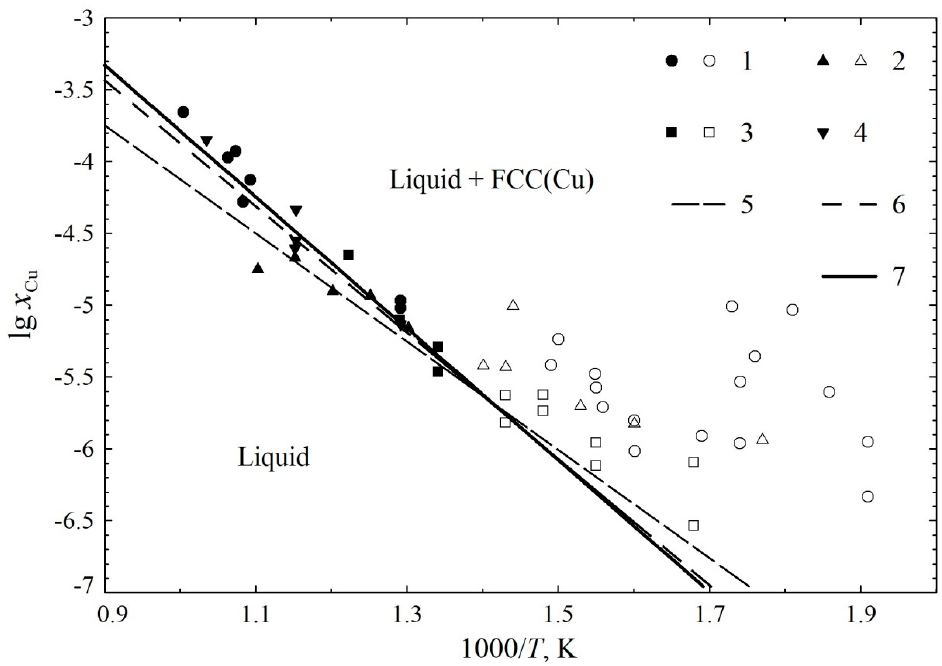
Figure 1. Approximation of experimental data on copper solubility in sodium. Experimental data according to [9]: 1—data from [10], 2—data from [11], 3—data from [12,13], and 4—data from [14].